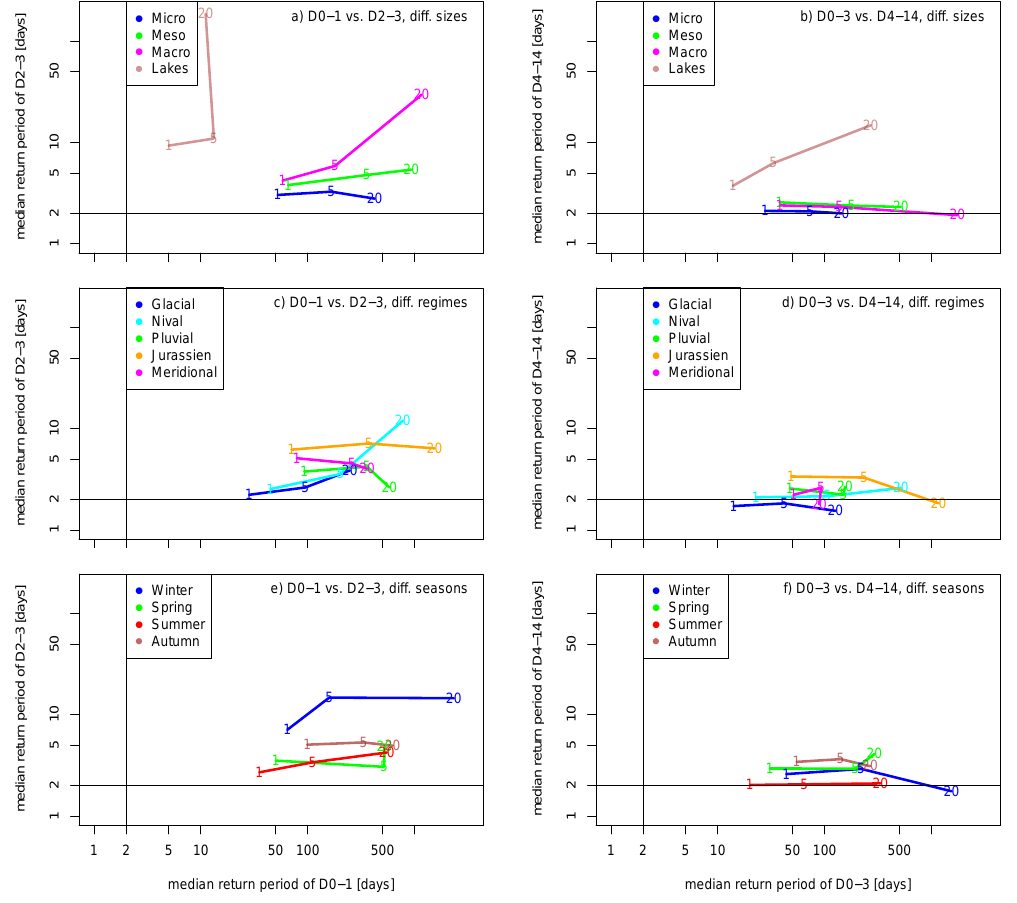
Figure 8. Median return periods of flood-associated precipitation for different flood samples. The rows show different catchment sizes (a, b) , different hydrological regimes (c, d) and different flood seasons (e, f) . The left column shows D0–1 in x and D2–3 in y and the right column D0–3 in x and D4–14 in y . The numbers 1, 5 and 20 indicate median return periods associated with all HQs, with all HQ5s, and with all HQ20s, respectively. They are joined together by a